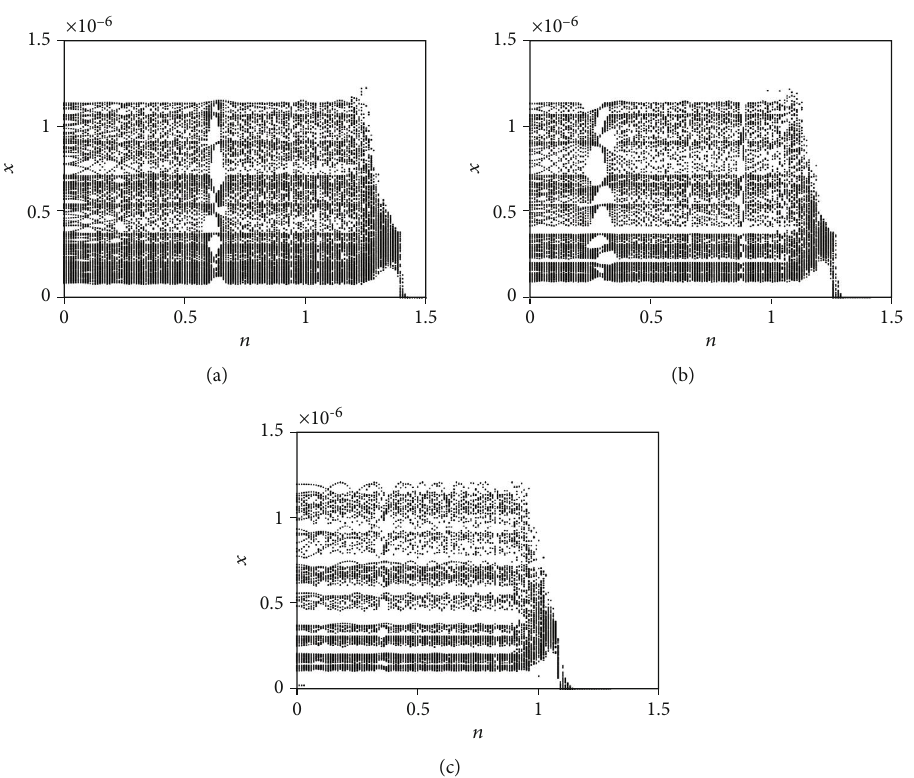
Figure 3: The bifurcations in system (2) versus parameter n with fractional orders (a) ϖ = 1 , (b) ϖ = 0 : 99